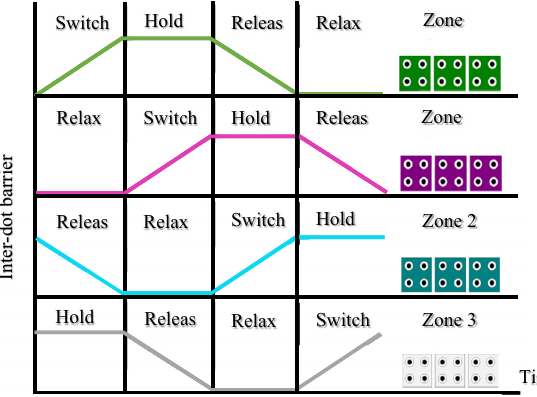
Figure 5: Clock signal zones and phases [ 26 ] .